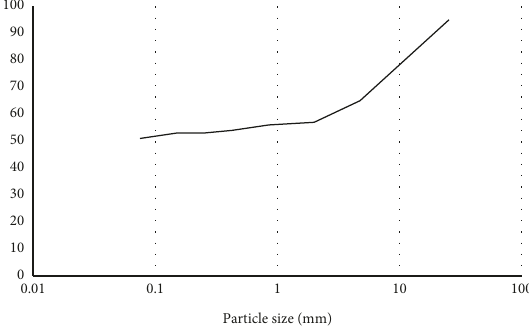
Figure 2: Soil granulation test.